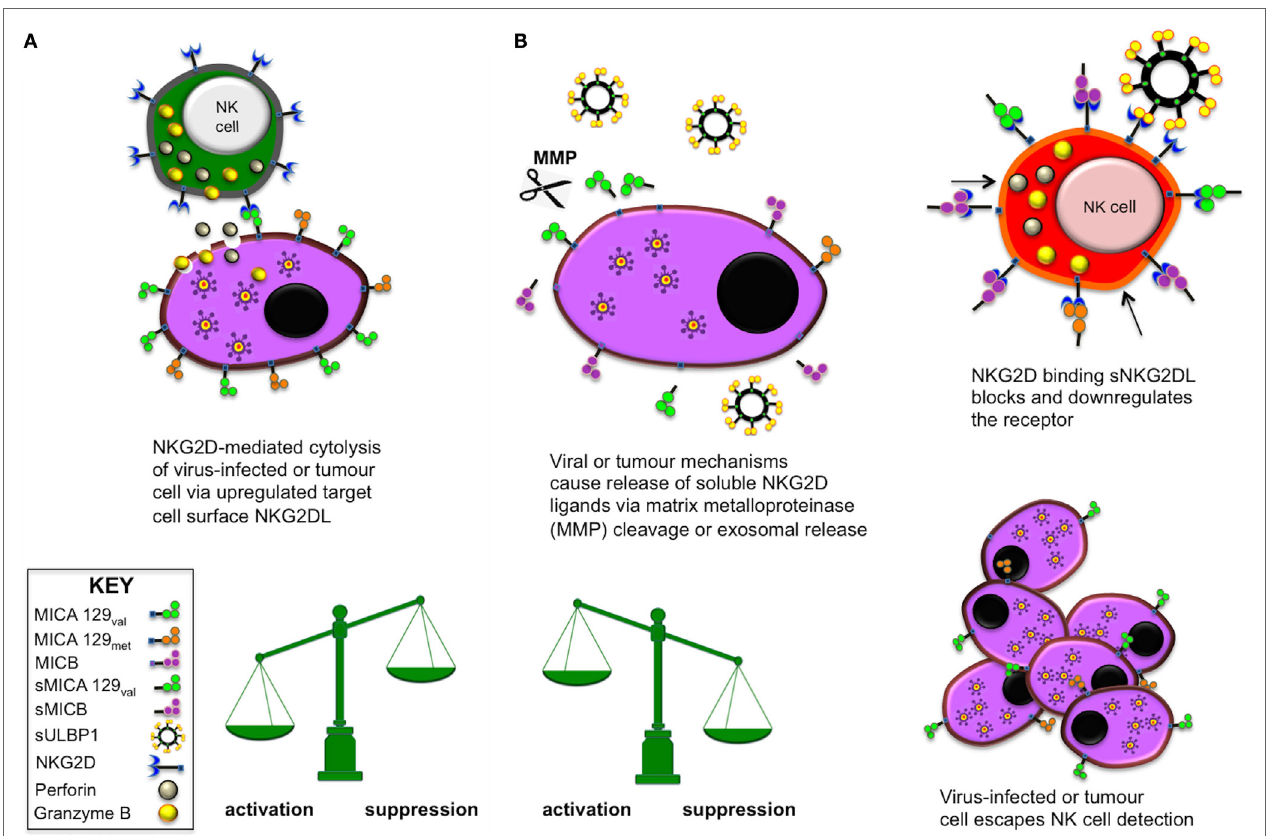
FigUre 1 | Natural killer (NK) cell activation and suppression via NK group 2, member D (NKG2D) engagement with membrane-bound or soluble NKG2D ligands (NKG2DLs), respectively. (a) When the activating receptor NKG2D on NK cells and various other lymphocytes interacts with stress-induced, upregulated NKG2DL on virus-infected or tumour cells, the target cell is eliminated by lytic actions of the effector cell. (B) Certain viruses and tumours are able to release soluble NKG2D ligands (sNKG2DLs) via MMP enzymatic cleavage or direct production of exosomal sNKG2DLs as molecular decoys. In this situation, the NKG2D activating receptor becomes blocked or is downregulated and the effector cell becomes anergic and unresponsive to further activation. This mechanism allows the tumour or virus to escape immune surveillance and